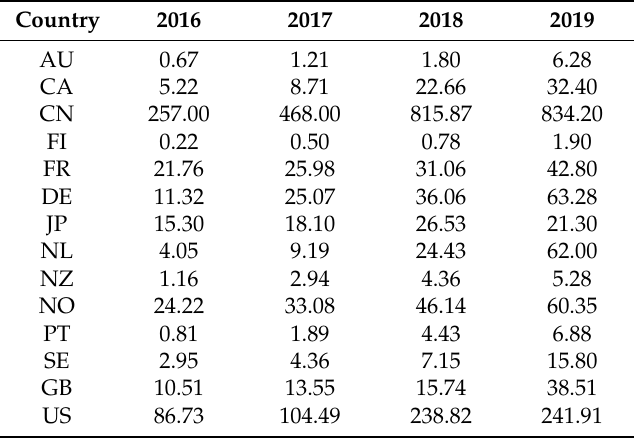
Table 3. Actual values of battery-electric car sales